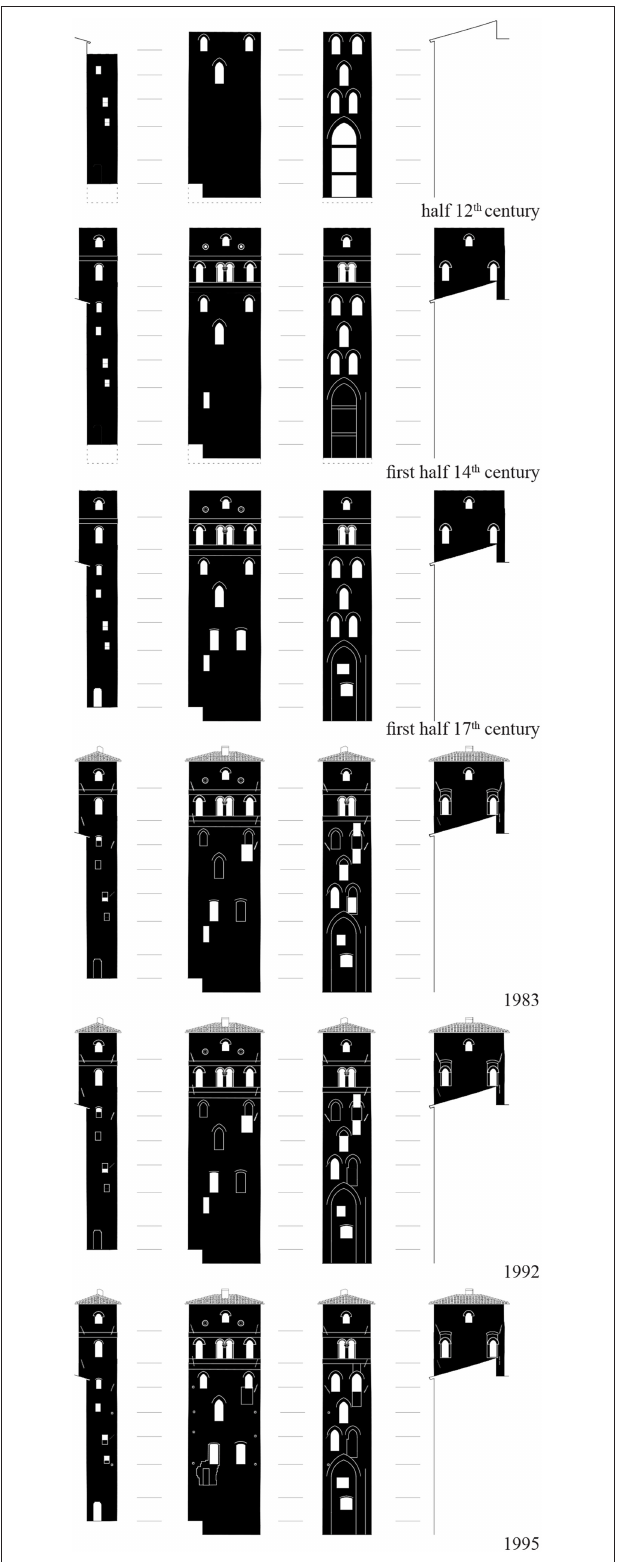
FIGURE 6 | Morphologic evolution hypotheses of the Lanfreducci Tower.